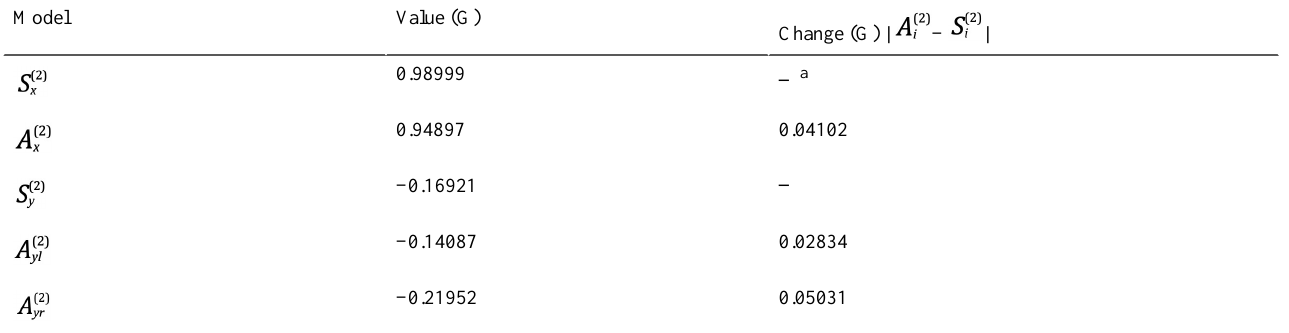
Table 2. Measurement results of user number 2 based on orthopedists’standards.